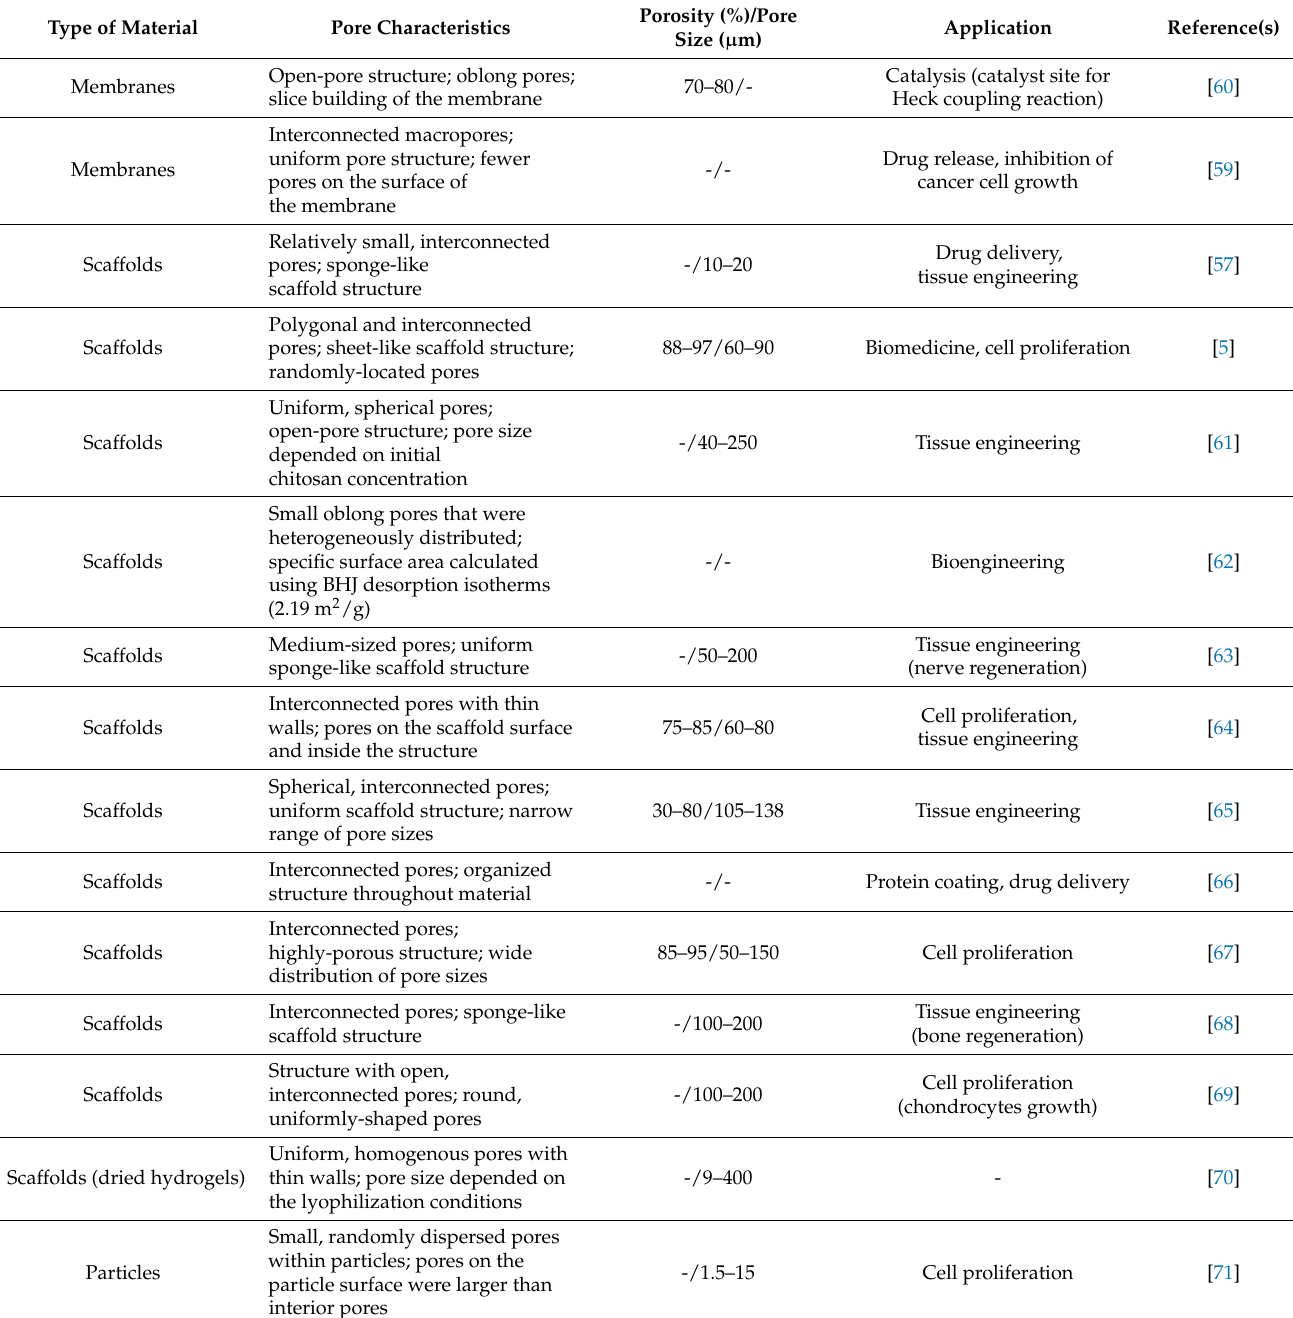
Table 1. Structure and applications of chitosan-derived porous materials obtained by